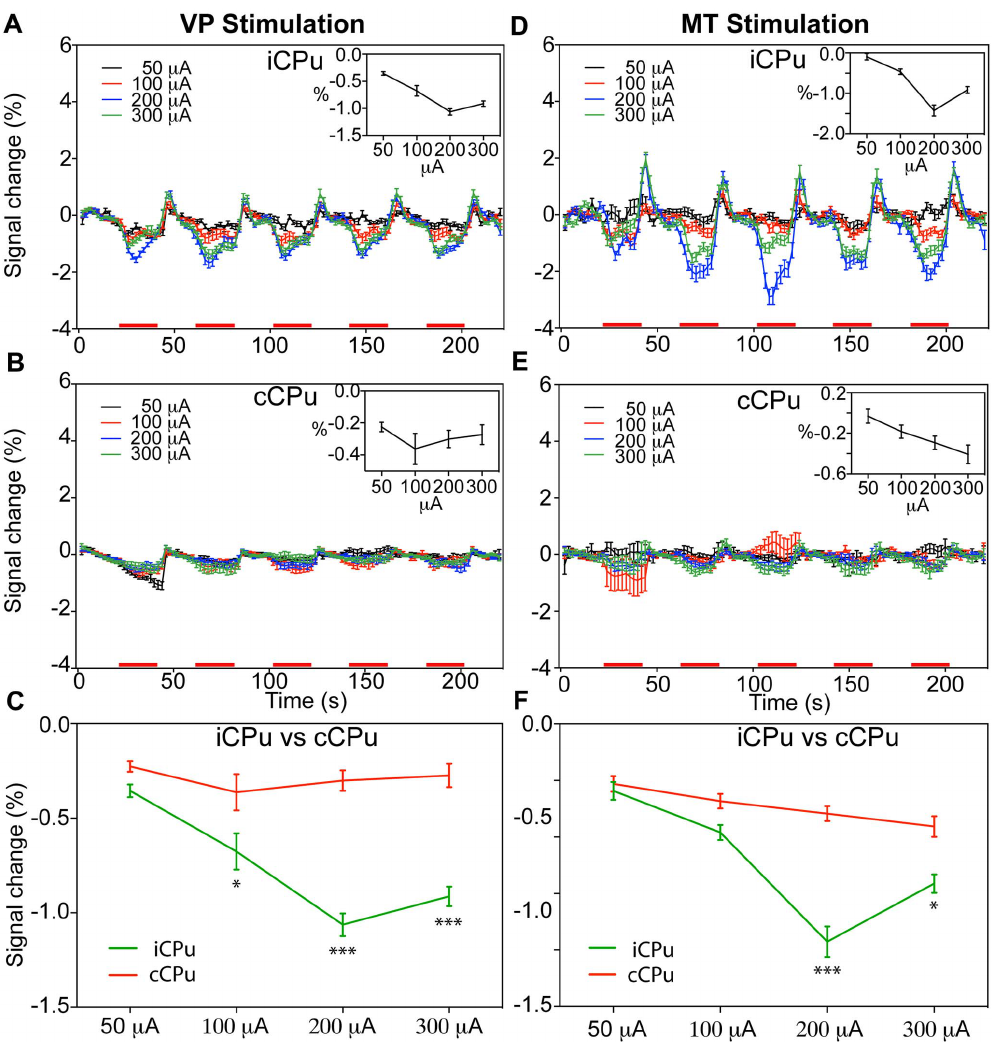
Figure 8. Comparison of negative BOLD responses in the CPu by thalamic stimulation intensities. Mean time course of BOLD responses (mean 6 SEM) induced by VP (A, B; n=4) and MT (D, E; n=6) stimulation in the iCPu and cCPu, depicted for various stimulus intensities. Red bars under the time axis show the periods of electrical stimulation. The mean BOLD response amplitude (average change, %) within five stimulus blocks is shown against the stimulus intensity in the inset and composited in (C) and (F). (* p , 0.05, *** p , 0.0005, two-way ANOVA with Newman-Keuls posttest).